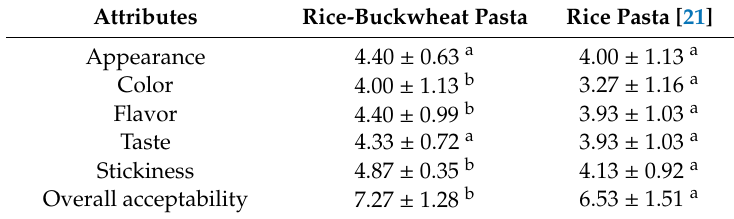
Table 6. Sensory attributes of optimum rice-buckwheat pasta in comparison to rice